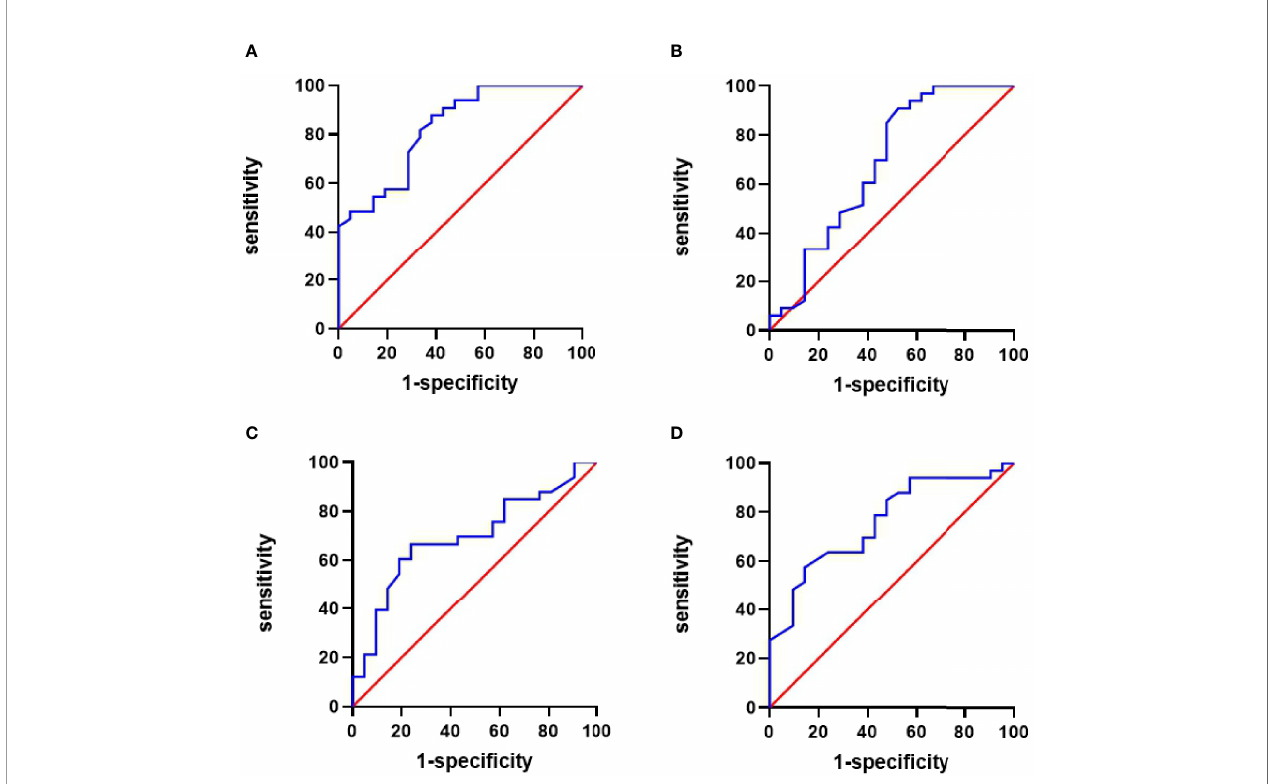
FIGURE 4 | Receiver operating characteristic (ROC) curve of cytokines for predicting the activity of TA patients. (A) The area under the ROC curve (AUC) of IL-6 was 0.827, sensitivity 87.9%, and speci fi city 61.9%. (B) AUC of IL-10 was 0.683, sensitivity 47.6%, and speci fi city 90.9%. (C) The AUC of IL-17 was 0.696, sensitivity 66.7%, and speci fi city 76.2%. (D) AUC of TNF- a was 0.762, sensitivity 57.6%, and speci fi city